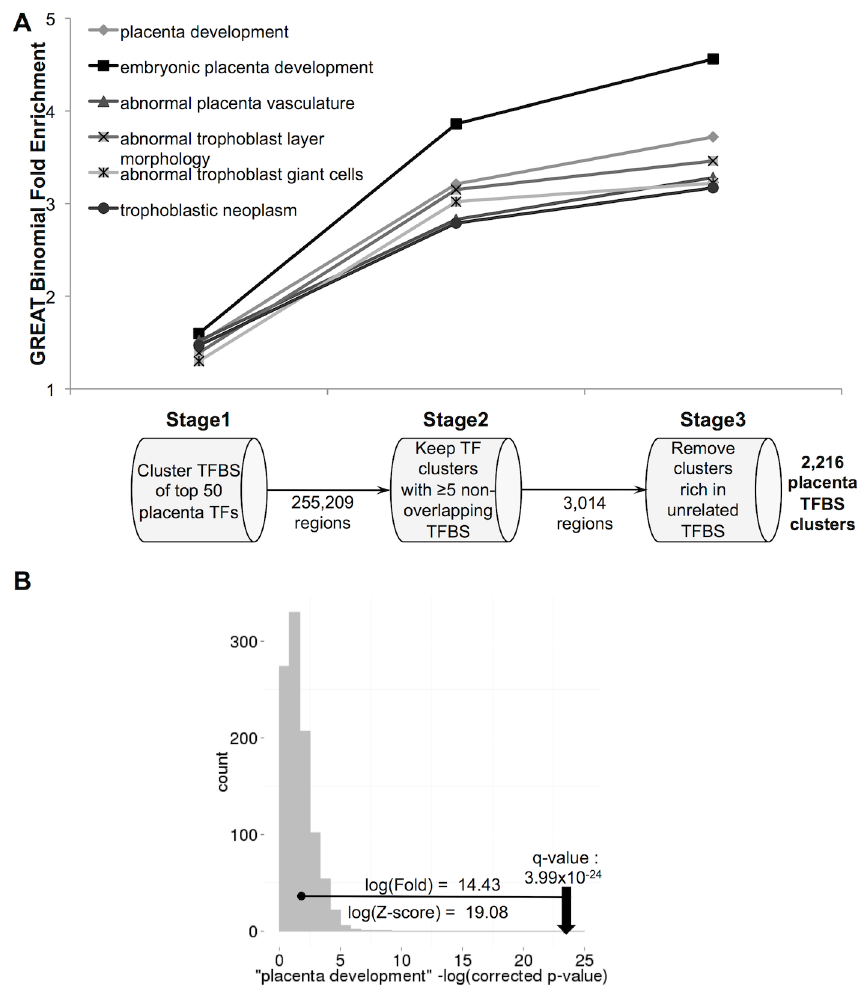
Figure 2. Identification of placenta TFBS clusters. (A) Three stages of data processing are used to identify placenta TFBS clusters. In stage 1, the top 10,000 predictions for the top 50 TFs were compiled, and binding site predictions in close proximity were clustered. In the second stage, clusters containing less than 5 non-overlapping binding sites were removed. In stage 3, regions that are rich in binding site predictions for TFs below rank 100 were removed. The filtering steps strongly enrich for placenta terms in GREAT, as shown by plotting the fold enrichment in each stage for six different terms. (B) Null model showing that choosing clusters with $ 5 non-overlapping TFBS enriches for clusters in the regulatory domain of genes involved in placenta development. Gray bars represent distribution of 2 log 10 (q-value) for ‘‘placenta development’’ term when 3,014 (size-matched to stage 2 in (A)) clusters are selected randomly from stage 1 in (A). Arrow points to 2 log 10 (q-value) when only clusters with $ 5 non-overlapping TFs are